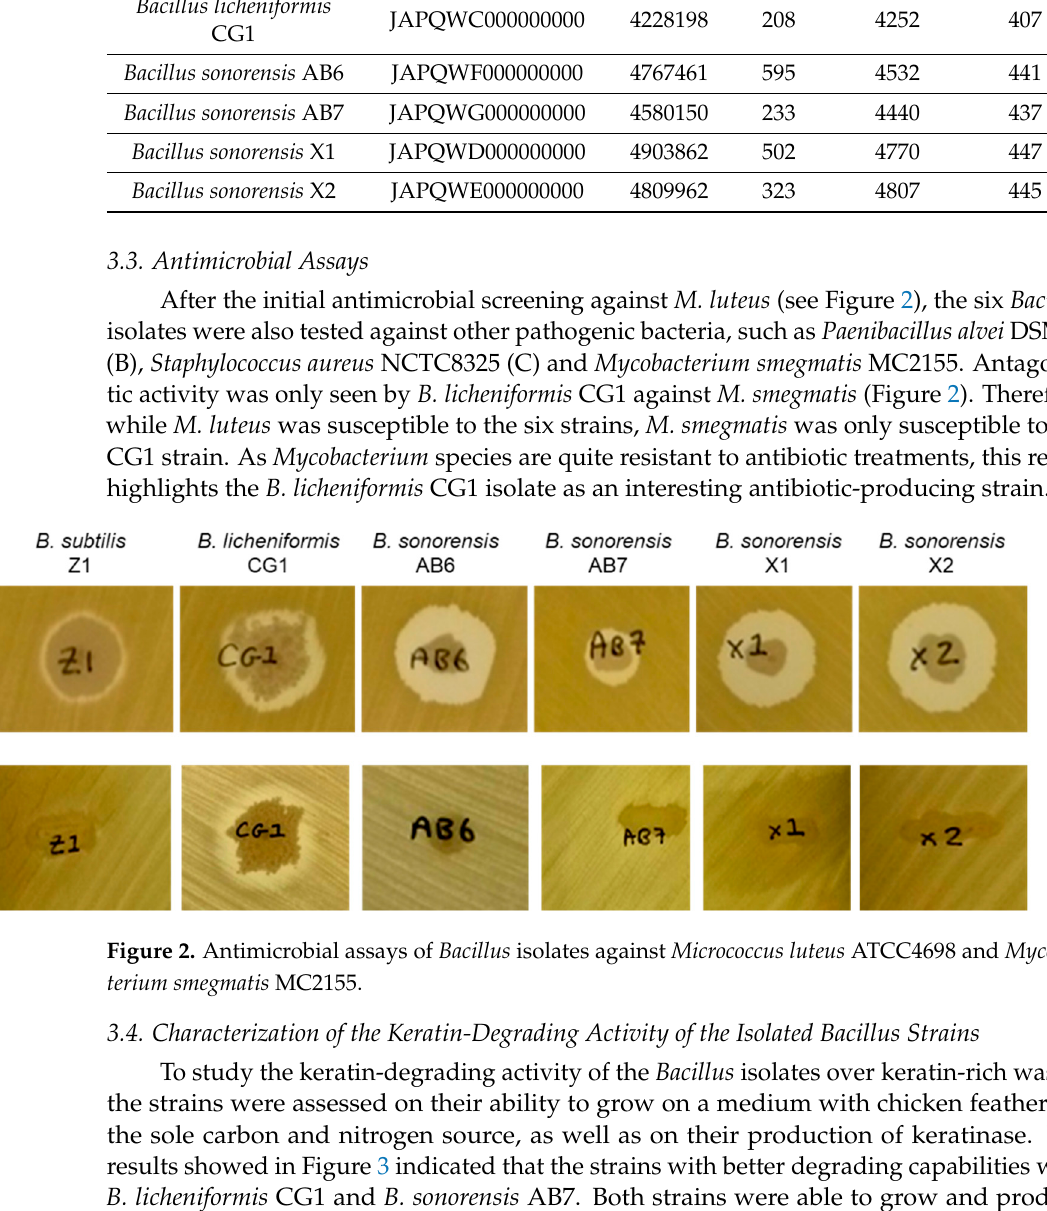
Table 3. Summary of the antimicrobial and keratinolytic activities obtained for each of the strains.